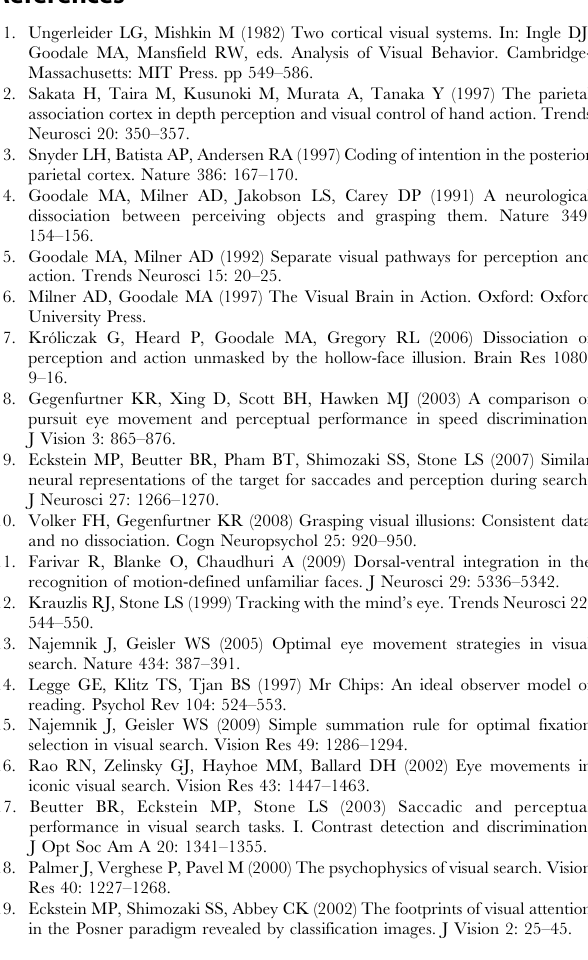
(templates) for perception (ventral stream) and saccadic action (dorsal stream) for search of an elongated Gaussian target in natural images. Video compares a pair of evolved perception and saccade templates and a pair of randomly generated